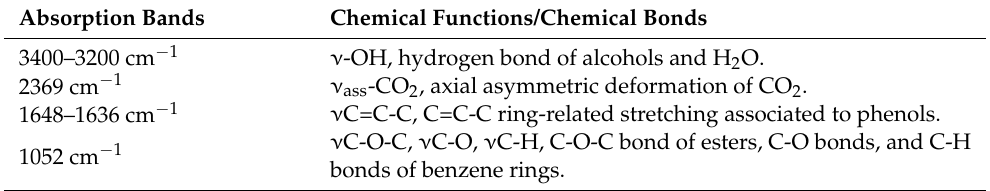
Table 6. Process parameters, mass balances, yields of reaction products (liquids, solids, H 2 O, and gas), and acidity of bio-oils by pyrolysis of Aça í seeds, activated with 2.0 M HCl solution, at 350, 400, and 450 ◦ C, 1.0 atmosphere, using a borosilicate glass reactor, in laboratory scale. Process Parameters. Mass of Aça í seeds (g) Yield of Bio-oil